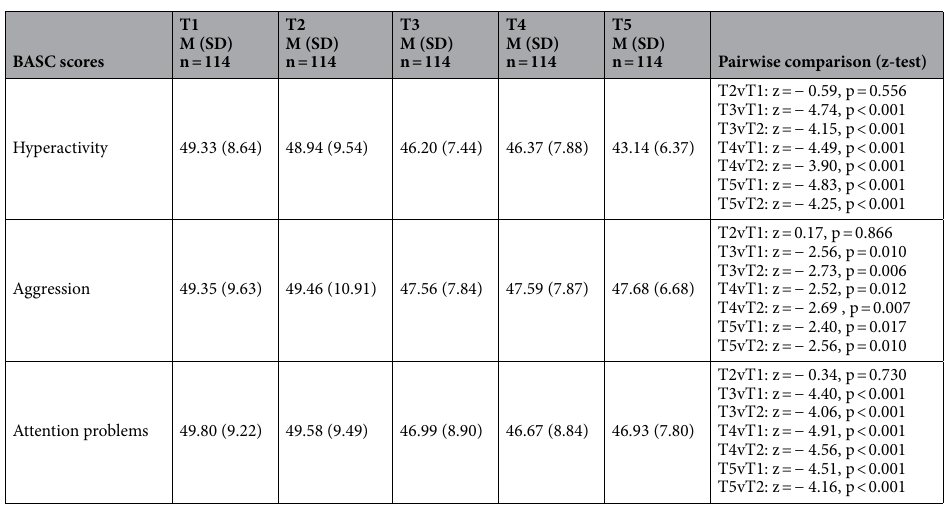
Table 3. Differences in BASC scores between the waitlist, active ENGAGE period, and both 2 and 6 months following the active ENGAGE period.